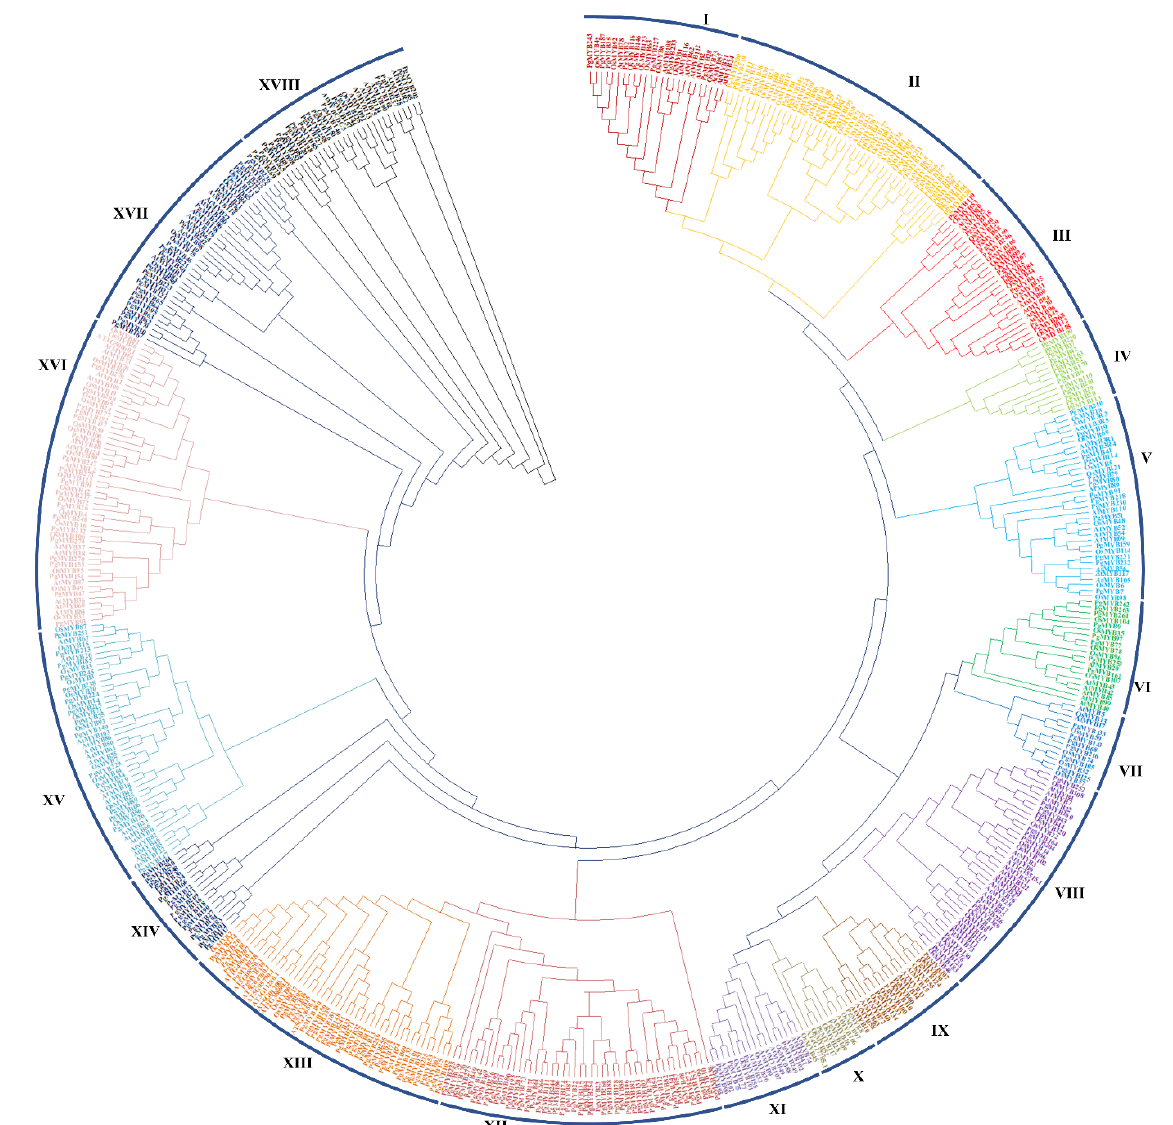
Figure 3. Phylogenetic tree of MYB family members of P. glaucum , A. thaliana and O. sativa. A total of 534 MYB proteins were aligned by Clustal, and tree was constructed by MEGA v7.0 using maximum likelihood method with 1000 bootstrap replication. The different groups are numbered from (I-XVIII).